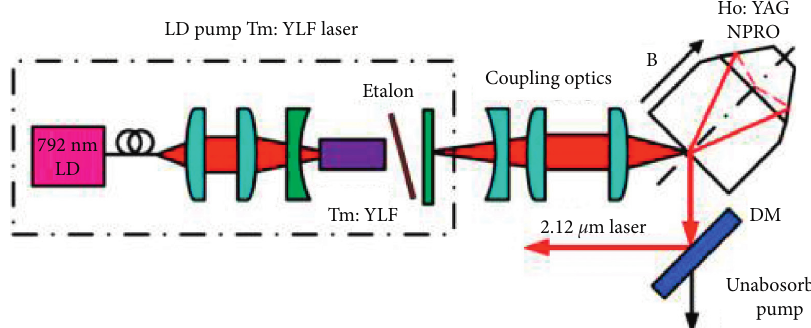
Figure 6: The experimental setup of a Ho:YAG NPRO laser [35].